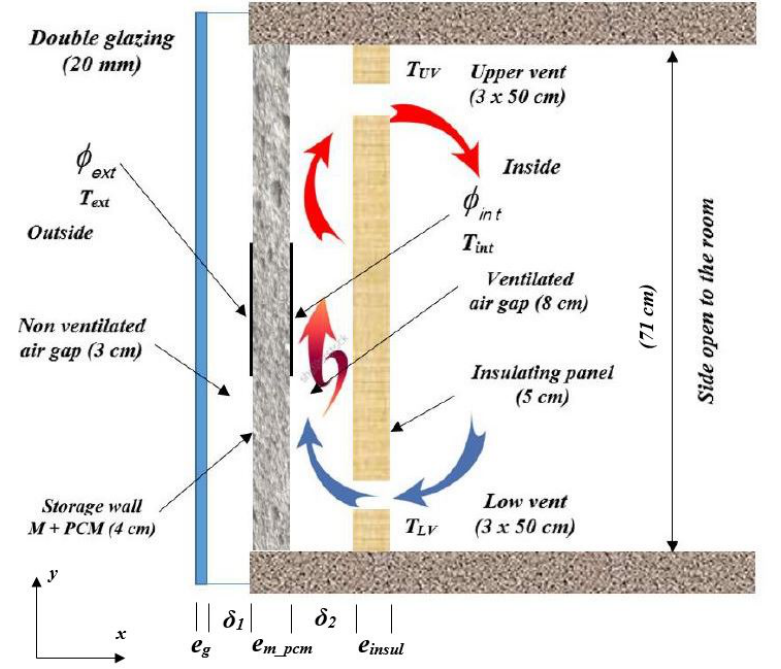
Figure 1. Vertical cross-section of the experimental